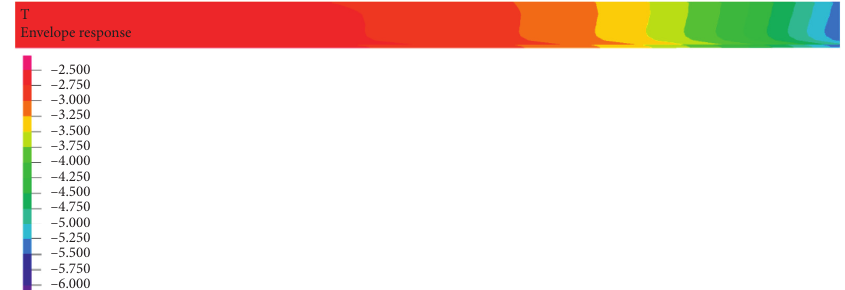
Figure 20: Annual average air temperature distribution outside the lining in the tunnel axis with a thermal conductivity of 0 W/(m · ° C).